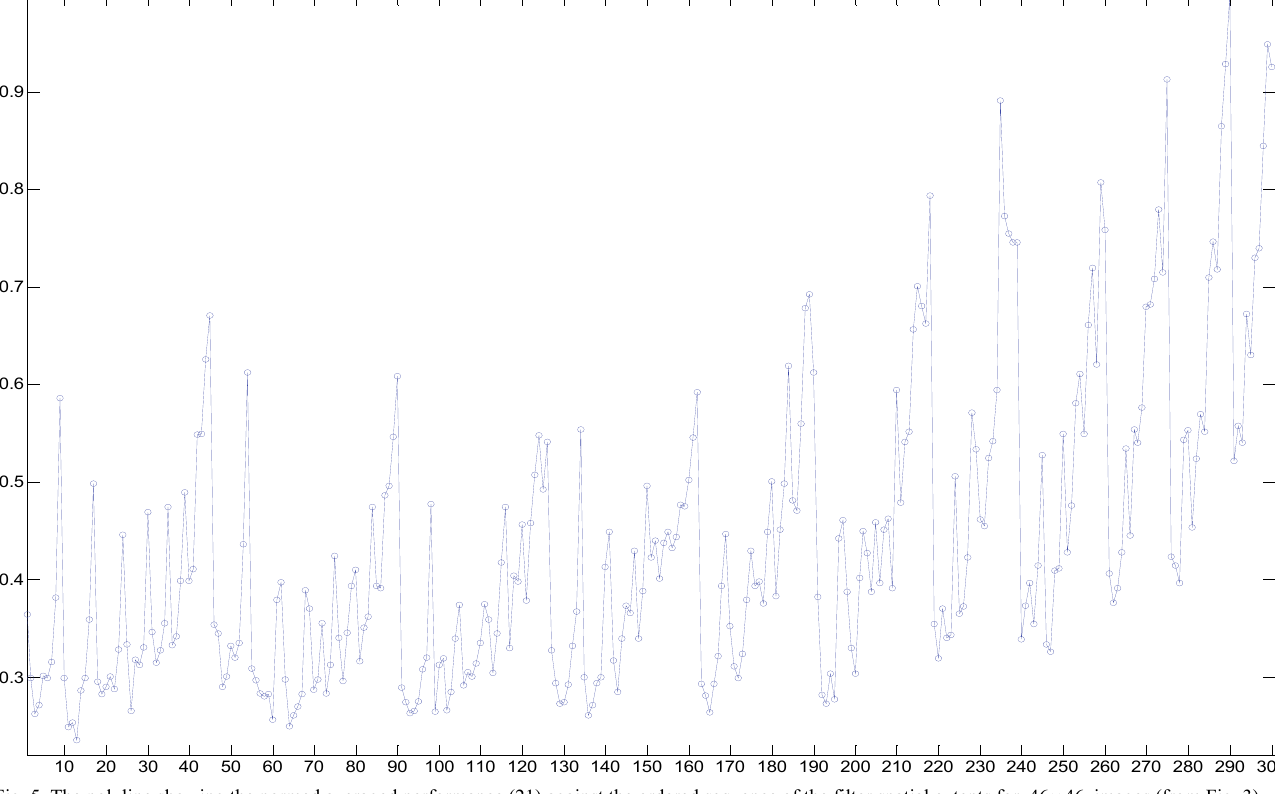
Fig. 5. The polyline showing the normed averaged performance (21) against the ordered sequence of the filter spatial extents for 46 46  images (from Fig.